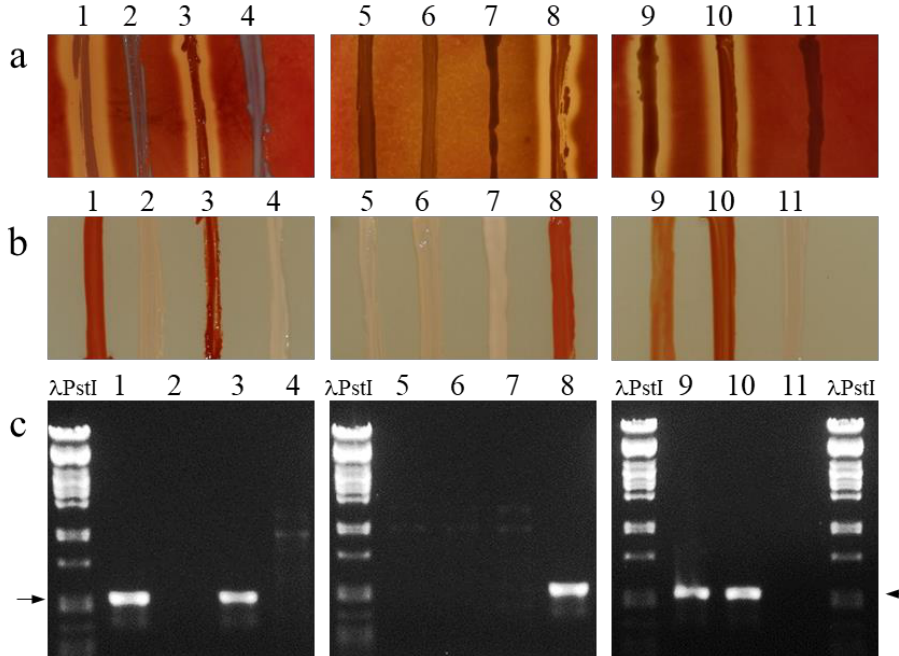
Figure 3. Identification of haemolytic, pigmented and cylG carrying strains. Appearance of a streak of bacteria after 7days incubation at 30 °C under anaerobic atmosphere on ( a ) sheep blood agar plate and ( b ) YEL agar plate. ( c ) PCR amplification products of cylG. Strains analysed: (1) A. jensenii JS279; (2) A. jensenii JS280; (3) A. jensenii DSM 20275; (4) A. jensenii DSM 20535; (5) A. jensenii DSM 20278; (6) A. jensenii DSM 20279; (7) A. jensenii DSM 20274; (8) A. virtanenii JS278; (9) A. thoenii DSM 20276; (10) A. thoenii DSM 20277; (11), P. freudenreichii DSM 20271. λPstI refers to phage lambda DNA digested with PstI. Arrows indicate the positions of the 514-bp band in the marker lanes. Representative results of experiments repeated at least three times are shown.